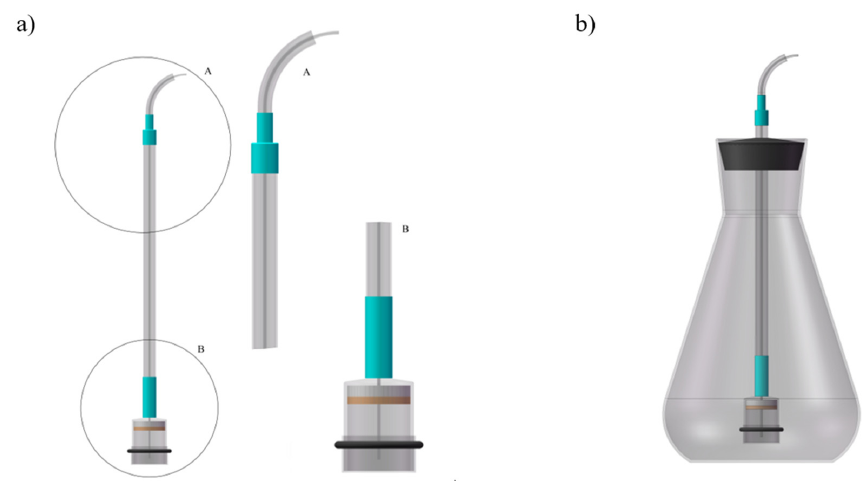
Figure 1. ( a ) Construction of the test probe, ( b ) probe in a mycelium in in vitro culture of A. bisporus flask (A—probe shaft, B—dipper).